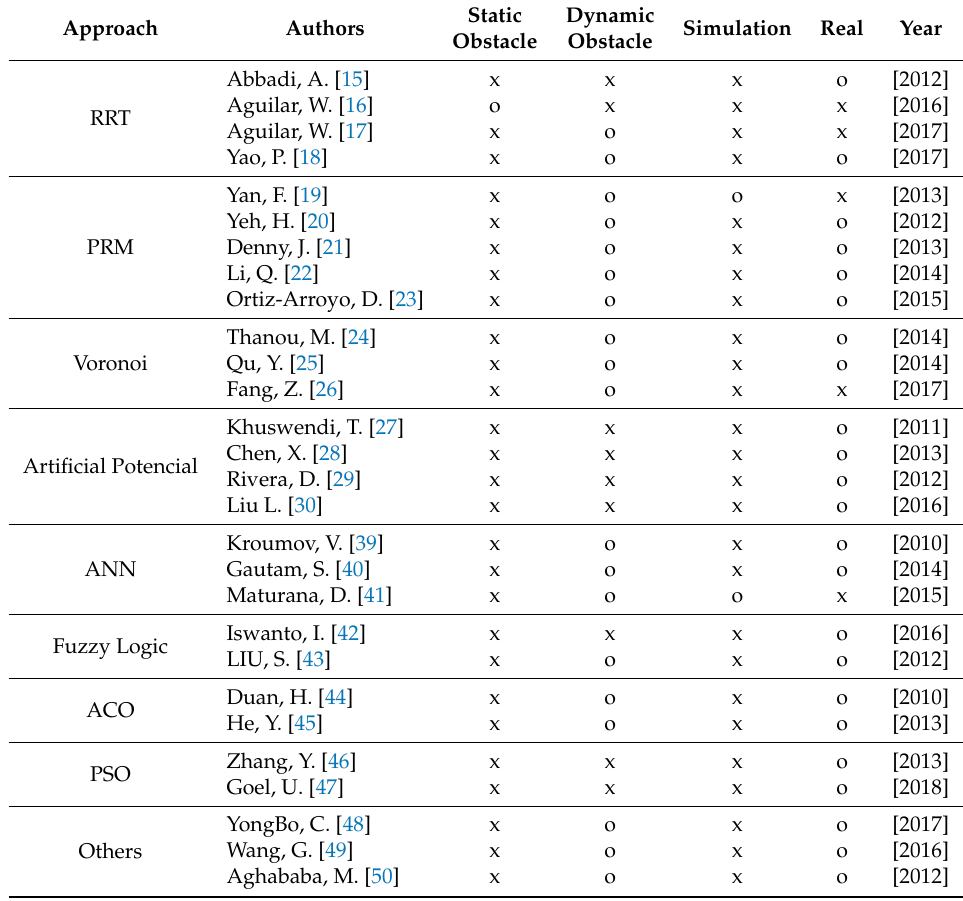
Table 2. 3D path planning methodologies studied